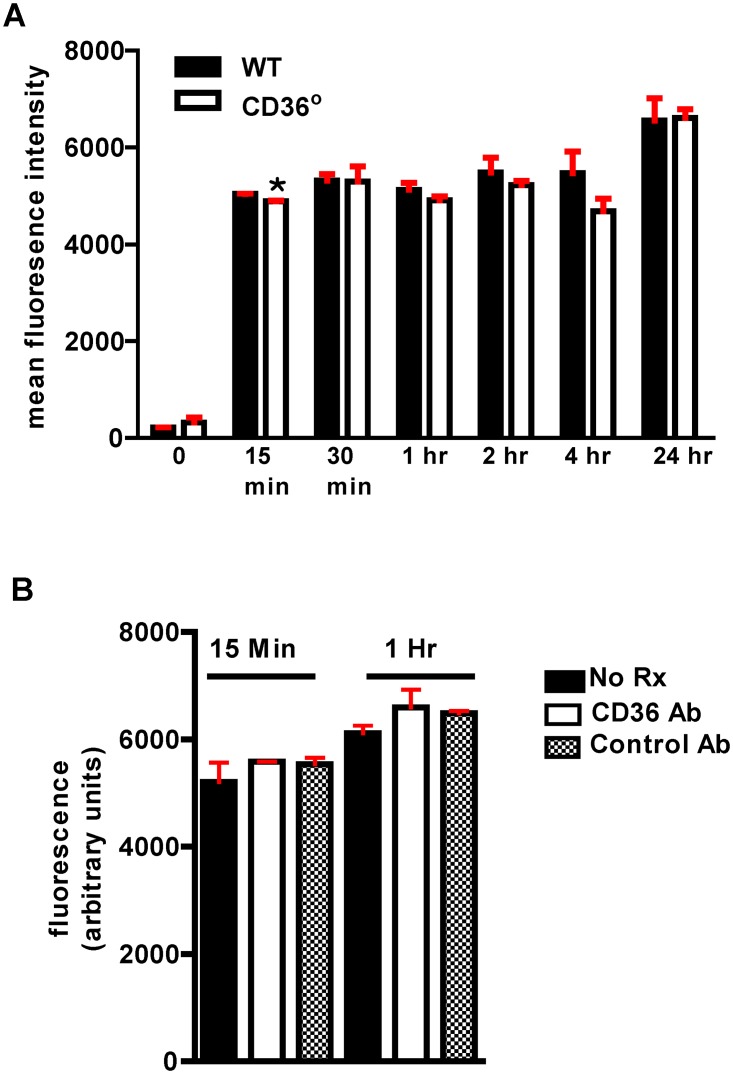
Pg bacteria interaction with macrophages is unaffected by CD36.
A. Interaction of Syto 17 labeled Pg bacteria with macrophages from WT and Cd36° mice showed no significant differences by flow cytometry analysis after 15 minutes co-incubation. *p<0.005, one-tailed unpaired t-test. B. Antibody to CD36 did not affect interaction of Syto 17 labeled Pg bacteria with WT macrophages. Experiment was performed in triplicate and repeated once.